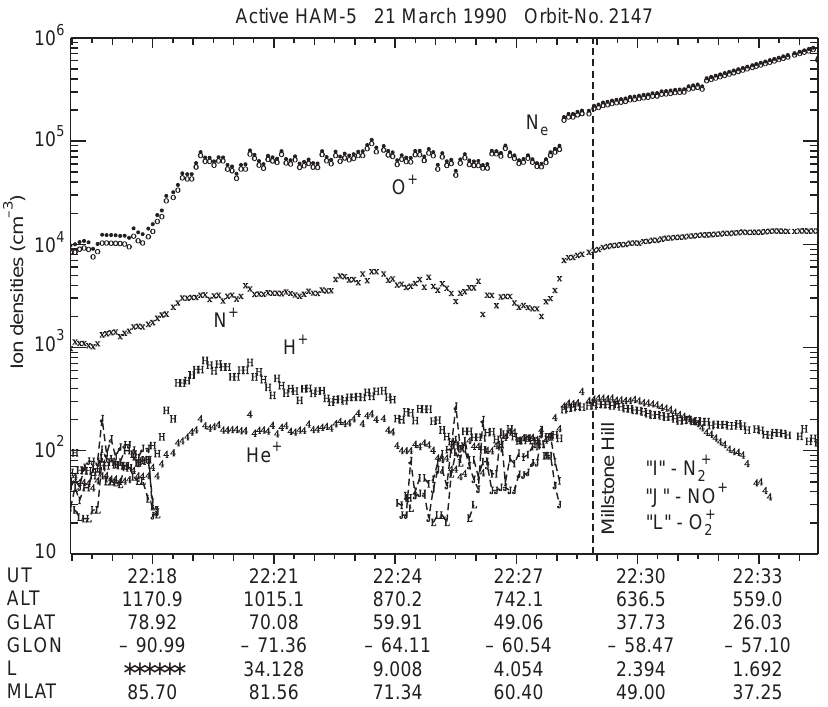
Fig. 8. HAM-5 ion spectrometer measure- ments along orbit 2174 of the Active main satellite on March 21, 1990, during its passage near the Millstone Hill incoherent scatter radar station. The ion densities are plotted versus UT. The satellite’s position along the orbital track is given below as altitude, geographic latitude and longitude, the Mc’Ilwain parameter and the local solar time. The crossing of the Millstone Hill L - value shell is indicated by a vertical